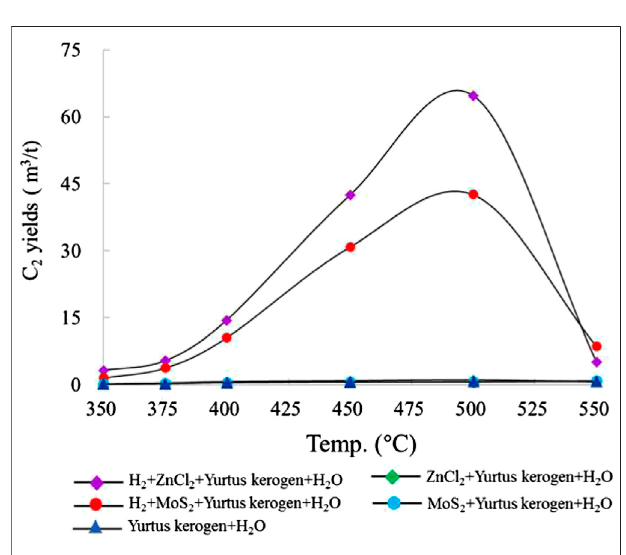
FIGURE 2 | Change in C 2 yield simulated under different catalytic hydrogenation control conditions of the closed